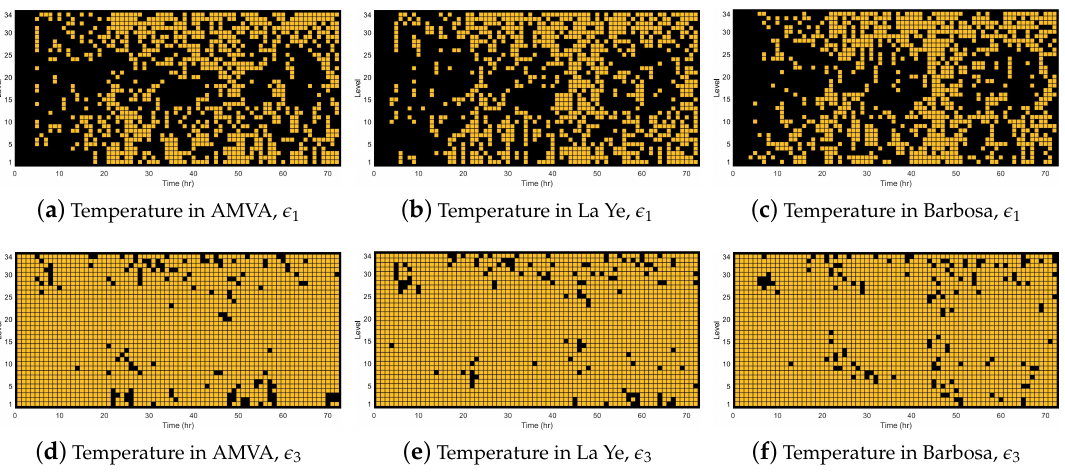
Figure 12. Rank test for the variable temperature with perturbation from (cid:101) 1 and (cid:101) 3 on time and levels. Yellow square represent that the null hypothesis was not rejected, black squares that it was